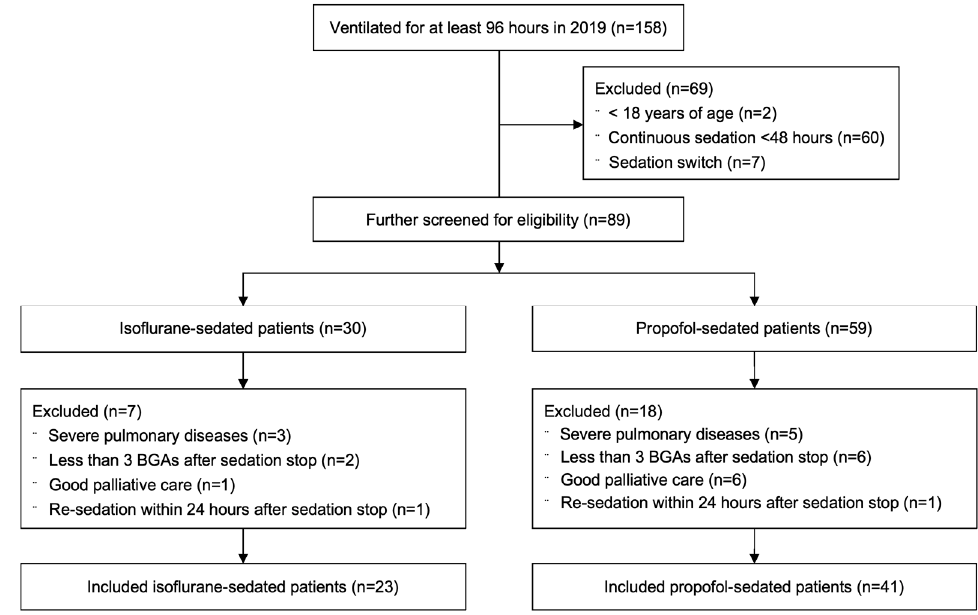
Figure 1. Patient flow chart.